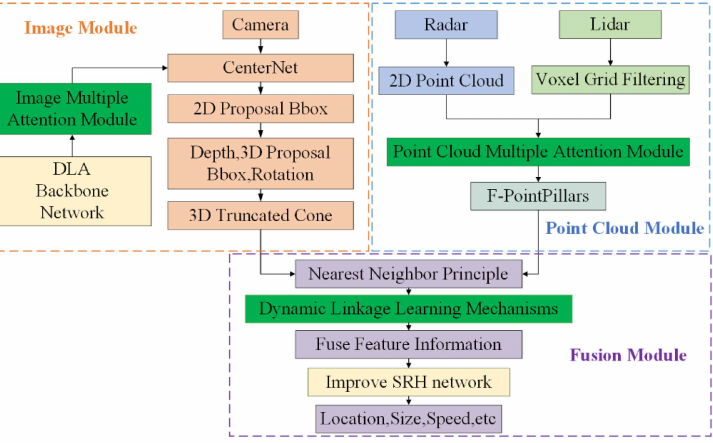
Figure 3. Multi-sensor information fusion system.